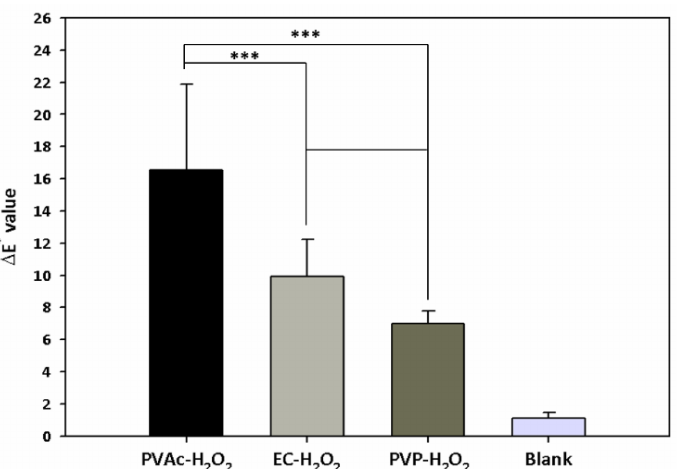
Figure 7. ∆ E values of various polymeric tooth whitening compositions after 1 h of treatment (in vitro). (significance codes; ***: p < 0.001).